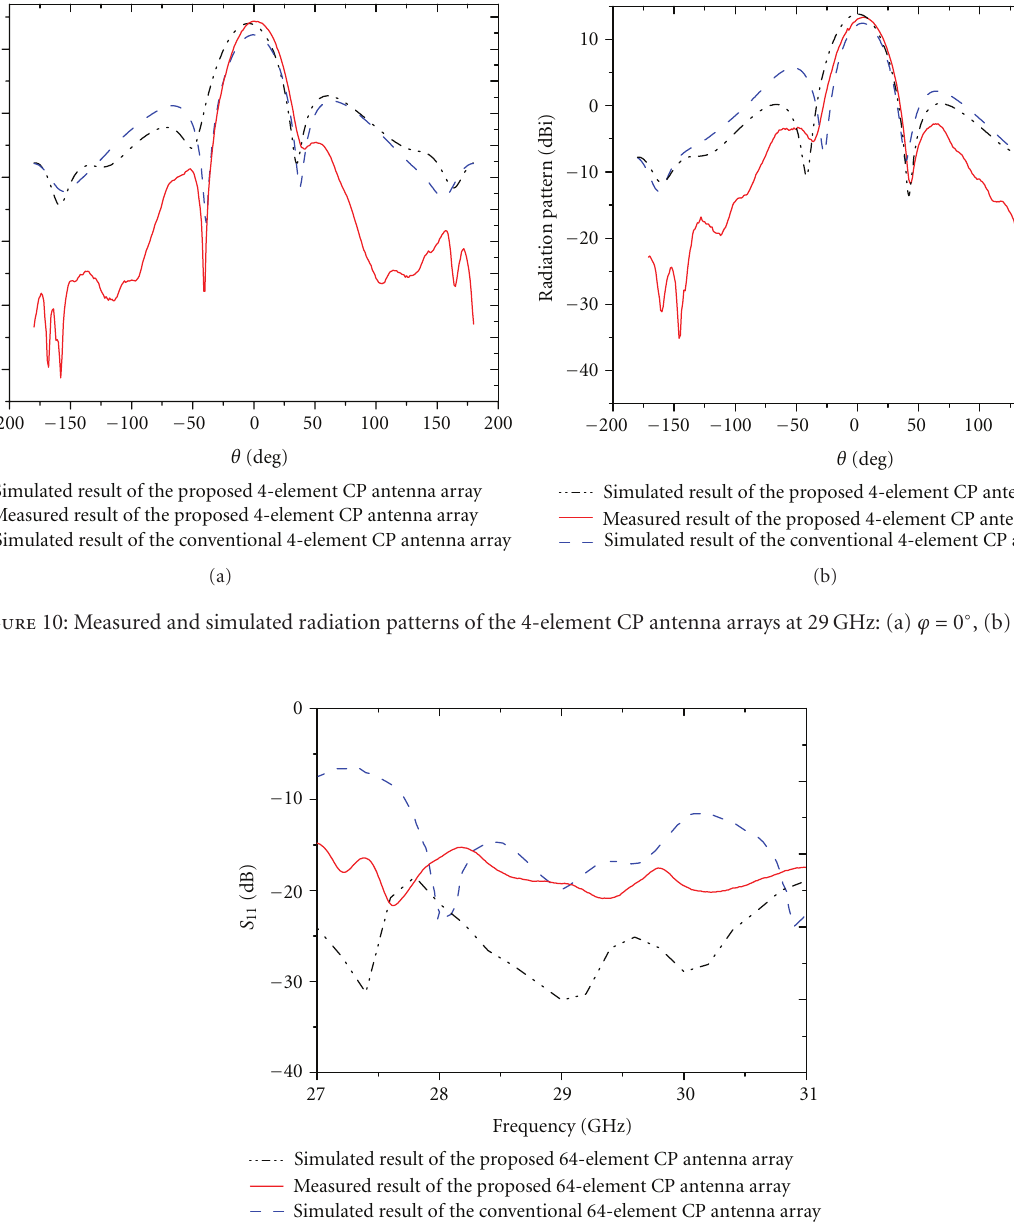
Figure 11: Measured and simulated S 11 of the 64-element CP antenna